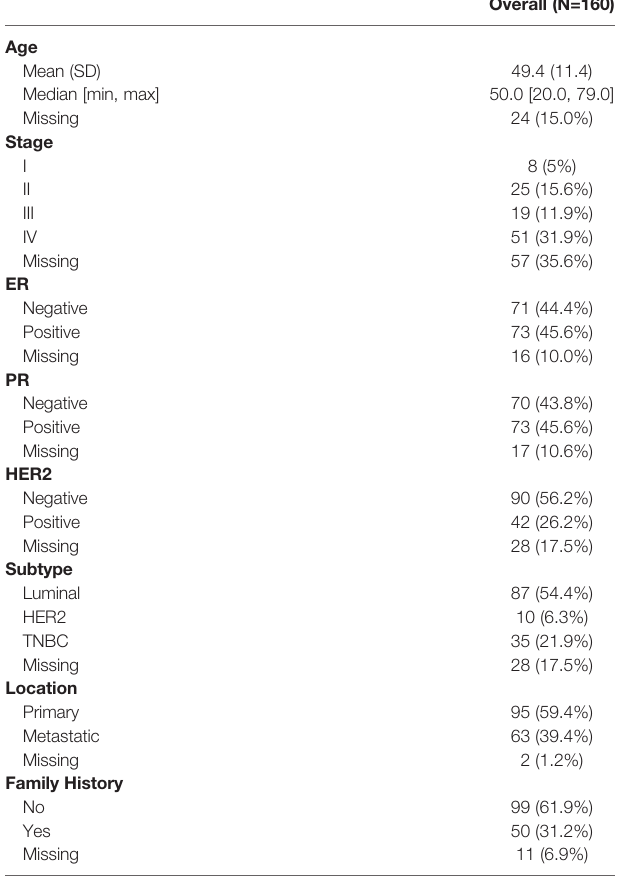
TABLE 1 | Clinical characteristics of